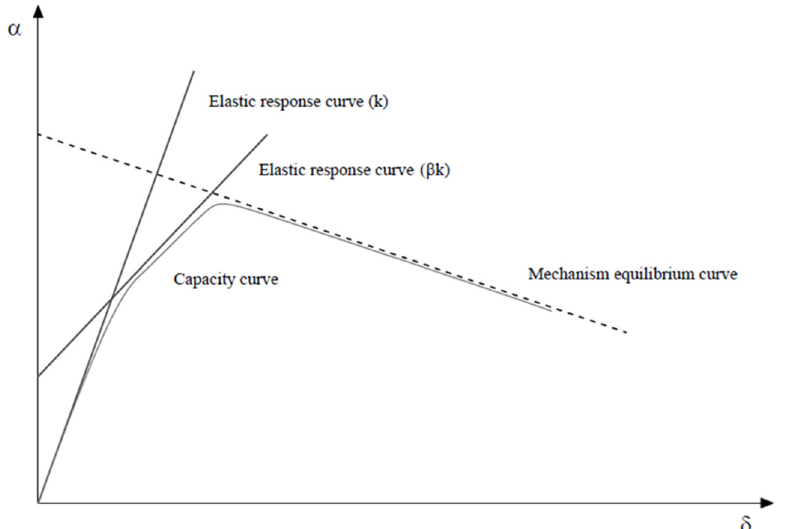
Figure 1. Trilinear approximation of the capacity curve for CBFs.